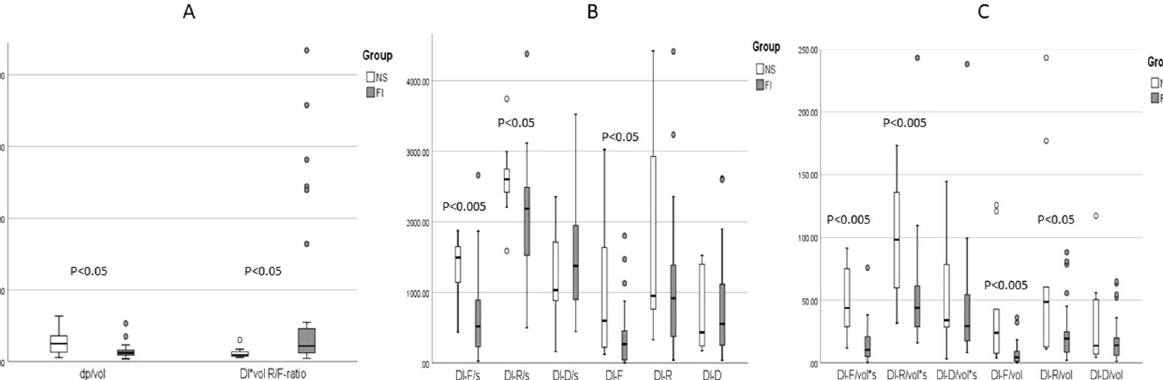
Figure 5. The three diagrams show comparative data of the Defecation Indices (DI). Most Defecation Indices show difference between normal subjects and FI patients. The box represents the interquartile range, which contains the middle 50% of the records. The line across the box indicates the median. The whiskers are lines that extend from the upper and lower edge of the box to highest and lowest values which are no greater than 1.5 times the IQ range. Outliers are cases with values between 1.5 and 3 times the IQ range, i.e., beyond the whiskers. See text for statistical values. F, R and D are the front, rear and delta pressure measurement, vol = volume and s =